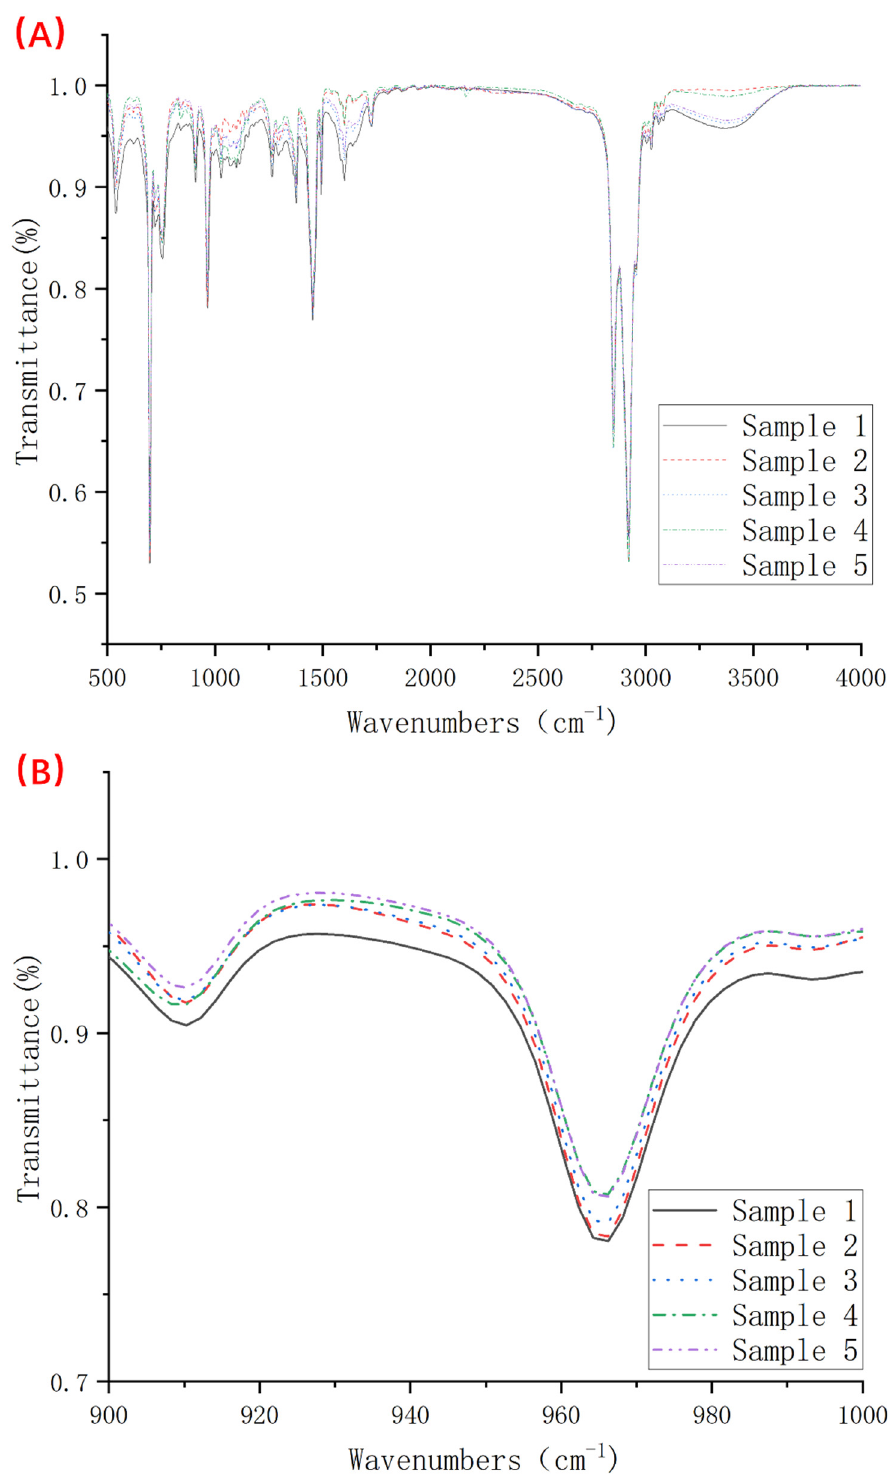
Figure 4. Infrared spectra of samples 1–5 (where ( A ) is the complete spectrum and ( B ) is the detailed image of the wave number 900–1000 cm − 1 ).